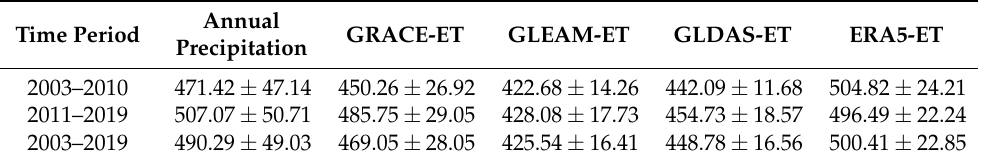
Table 1. Annual mean precipitation and annual cumulative evapotranspiration (ET) of different products in different periods in the Yellow River Basin (unit: mm). GRACE—Gravity Recovery and Climate Experiment; GLEAM—Global Land Evaporation Amsterdam Model; GLDAS—Global Land Data Assimilation Systems. Time Period